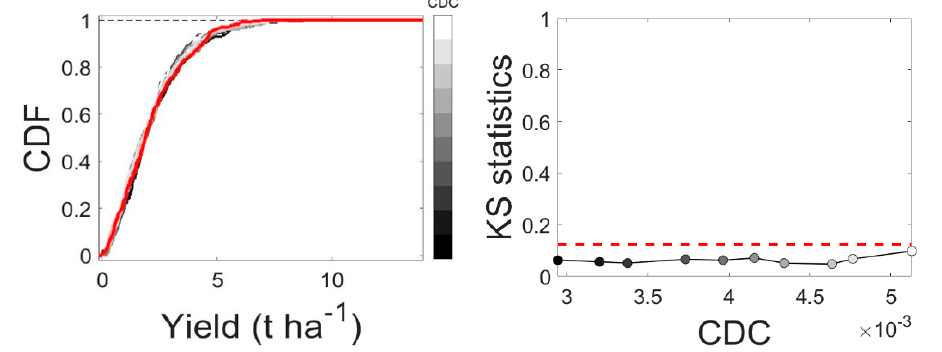
Figure 6. Cumulative Distribution Function (CDF) for the CDC parameter (left), red line on the left plot indicates the unconditional CDF and the grey colors represent the conditional CDF for ten different sampling points and Kolmogorov–Smirnov statistics (right), red dashed line indicates the critical value of Kolmogorov-Smirnov (KS) statistics at 95% confidence interval.